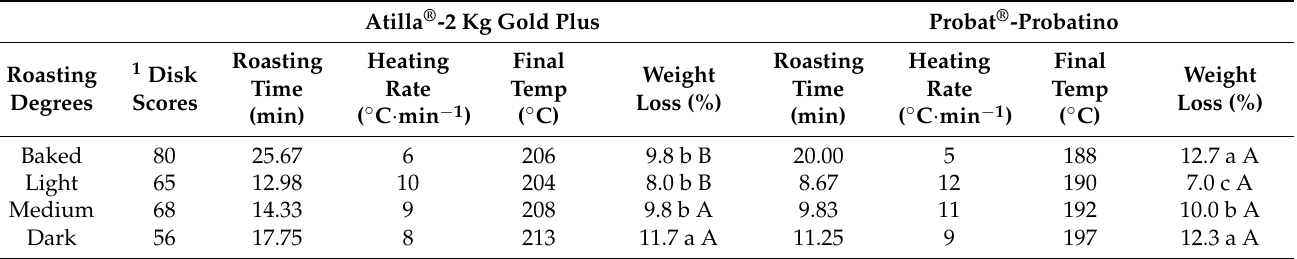
Table 2. Roasting conditions for both coffee roasters to achieve four degrees of roast. Atilla ® -2 Kg Gold Plus Probat ®